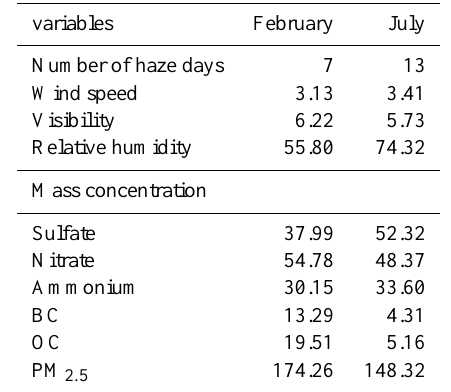
Table 3. The number of haze days in February and July in Beijing. Also shown are the regional- and temporal-average surface wind speed (ms − 1 ), visibility (km), relative humidity (%), and mass con- centrations (µgm − 3 ) of sulfate, nitrate, ammonium, BC, OC, and PM 2 . 5 during the haze days in February and July in